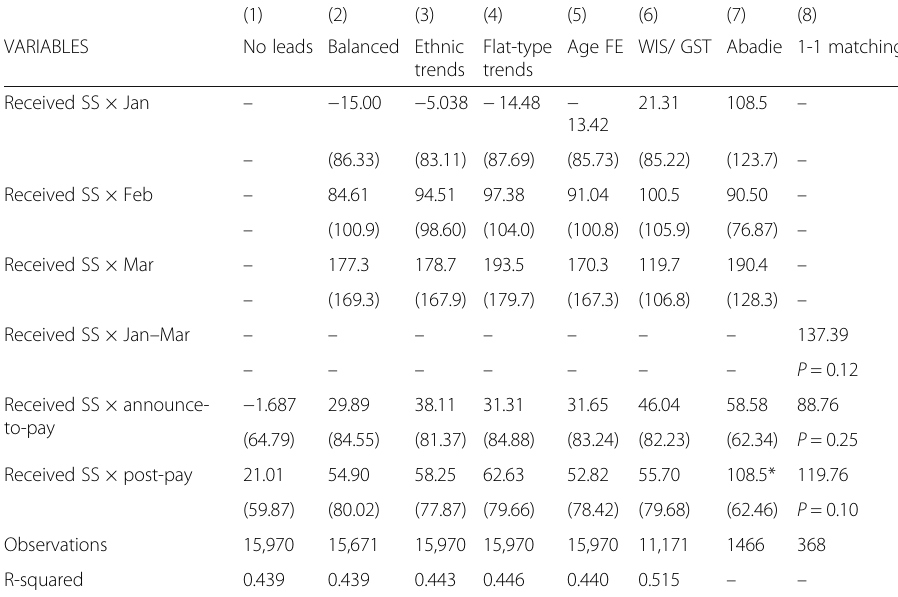
Table 29 Robustness check for impact of receiving SSS payouts on